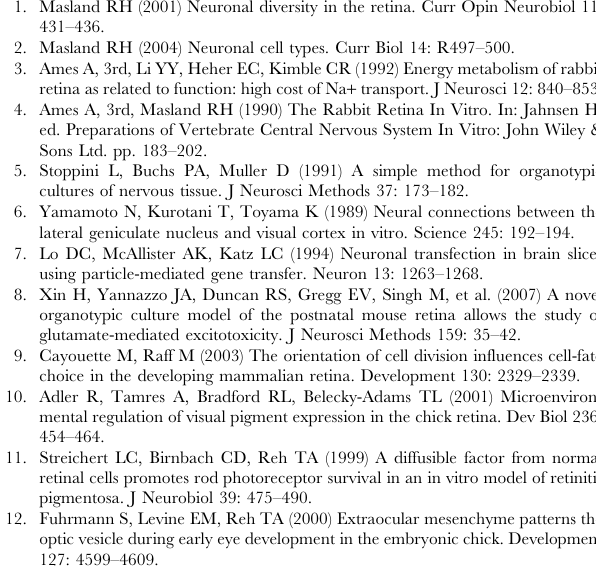
Figure S3 Calculation of temporal response jitter to the presentation of repeated full-field flicker. Panel A, responses to 25 repeats of the same stimulus are shown as rasters in which each row represents a 5 sec segment of the neural response, and each dot represents the time of occurrence of a spike. Panel B, a narrow peak in the post-stimulus time histogram in the marked area in panel A, expanded and binned at 1 msec resolution. The PSTH histogram can be approximated by a Gaussian, the width thereof represents the temporal jitter. Note that in the histogram multiple spikes of one firing event are averaged. Found at: doi:10.1371/journal.pone.0000221.s003 (1.08 MB TIF) Figure S4 High-resolution image of a Mueller cell. Panel A, B, and C, different views of a volume reconstruction of a Mueller cell from 353 individual image planes. Views from the scleral side (panel A), the vertical plane (panel B), and the vitreal side (panel C) are shown. Scale bar, 20 m m. The 12 images mounted below correspond to individual image planes at the positions indicated in B. Found at: doi:10.1371/journal.pone.0000221.s004 (5.43 MB TIF) Figure S5 High-resolution image of an ON cone bipolar cell. Panel A & B, two different side views of a volume reconstruction of a cone bipolar cell from 153 individual image planes. Panel C, dendrites and cell body seen from the scleral side, the axon has been cropped out. Panel D, axonal termination of the same bipolar cell. The extent of the axonal termination is indicated by a white polygon. The thicker processes seen in the picture belong to a ganglion cell close by that was also labeled. Scale bars for all panels, 10 m m. Found at: doi:10.1371/journal.pone.0000221.s005 (6.31 MB